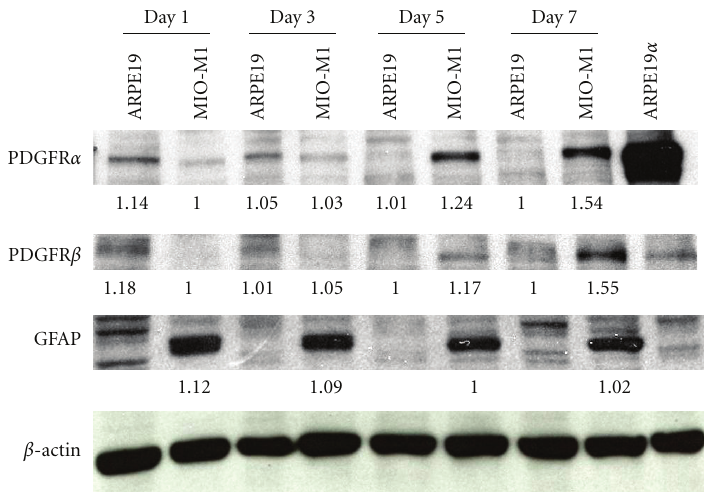
Figure 2: Western blot analysis of coculture samples at days 1, 3, 5, and 7 shows noticeable increases in PDGFR α expression in MIO-M1 MPCs. Transfected ARPE19 cells with increased expression of PDGFR α (RPE α ) are used as control for comparison. PDGFR β levels remain relatively low in both cell types throughout the course of the experiment, with a small increase in MIO-M1 MPCs on day 5 and a more significant increase by day 7. MIO-M1 cells show a small but measurable and consistent decrease in expression of GFAP between days 1 and 7 of the experiment. RPE α cells are included for control. Protein concentrations were standardized by Bradford assay. Band intensity was standardized by β -Actin expression (shown). Relative expression ratios are shown.